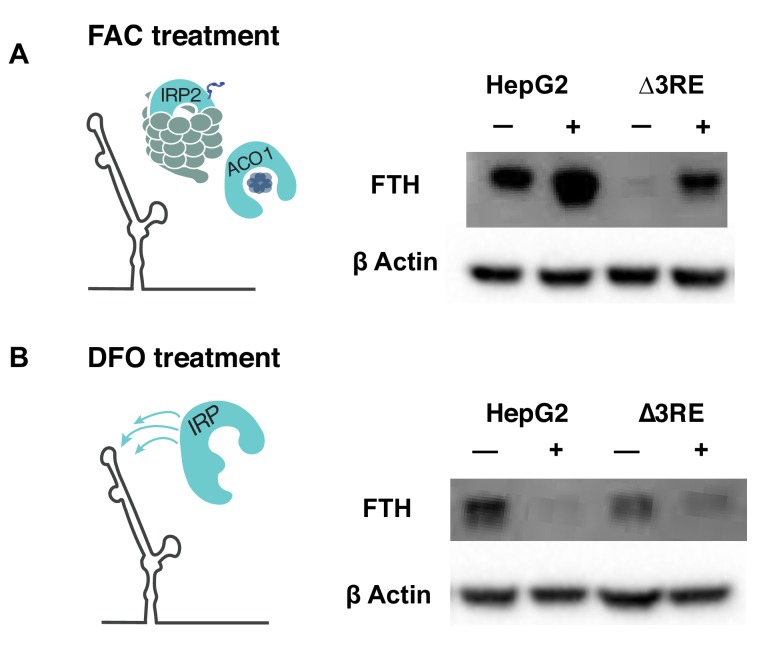
Physiological effects of the endogenous removal of the 3RE on FTH protein levels.(A, B) Representative western blots of FTH levels in the edited (∆3RE) and WT HepG2 cells under various iron conditions. (A) Iron donor treatment with FAC at 50 µg/mL for 24 hr; (B) Iron chelation treatment with DFO at 200 µM for 24 hr.